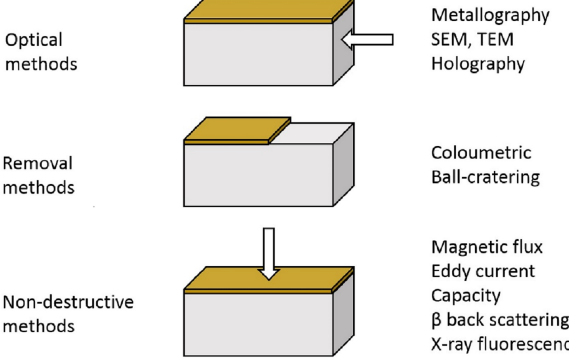
Figure 1: Optical, removal and non-destructive methods used for measuring the thickness of the anti-wear